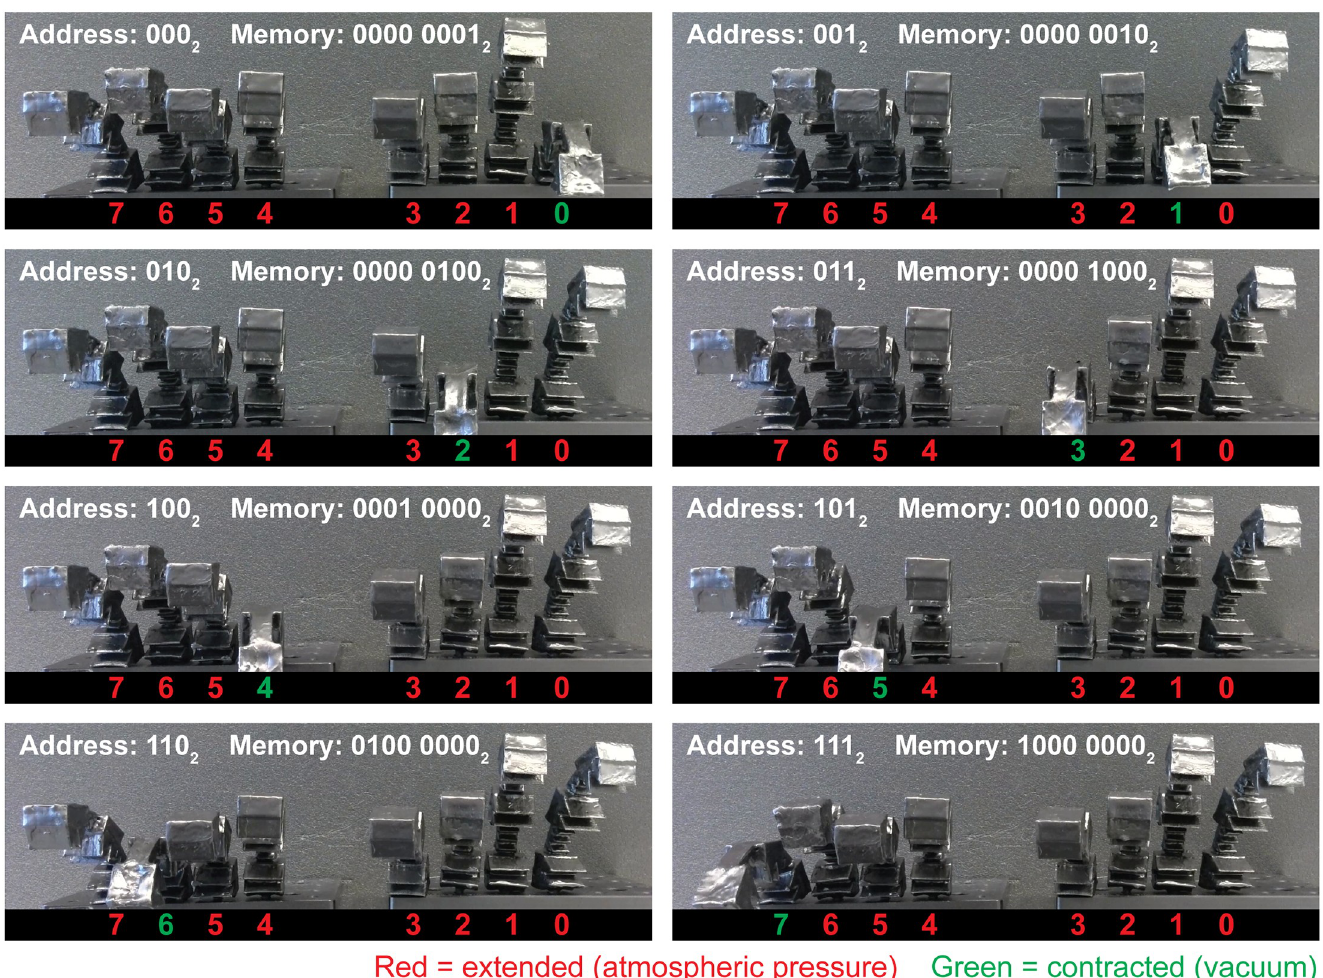
Fig 7. Video frames from using the pneumatic eight-bit RAM to contract eight soft robotic fingers one-at-a-time. The pneumatic RAM cycles through all eight addresses from 000 2 to 111 2 to set the pneumatic RAM’s memory to the values shown (from 0000 0001 2 to contract just Finger 0, to 1000 0000 2 to contract just Finger 7).